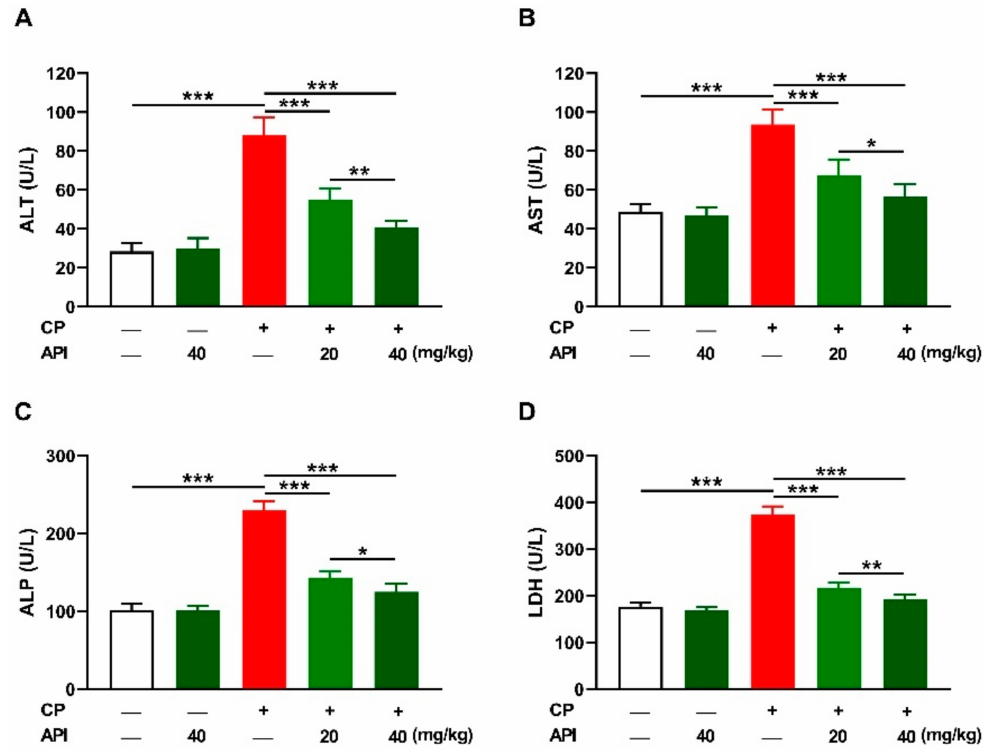
Figure 2. API ameliorated serum ( A ) ALT, ( B ) AST, ( C ) ALP, and ( D ) LDH in CP-intoxicated rats. Data are mean ± SEM, ( n = 6). * p < 0.05, ** p < 0.01, and *** p <